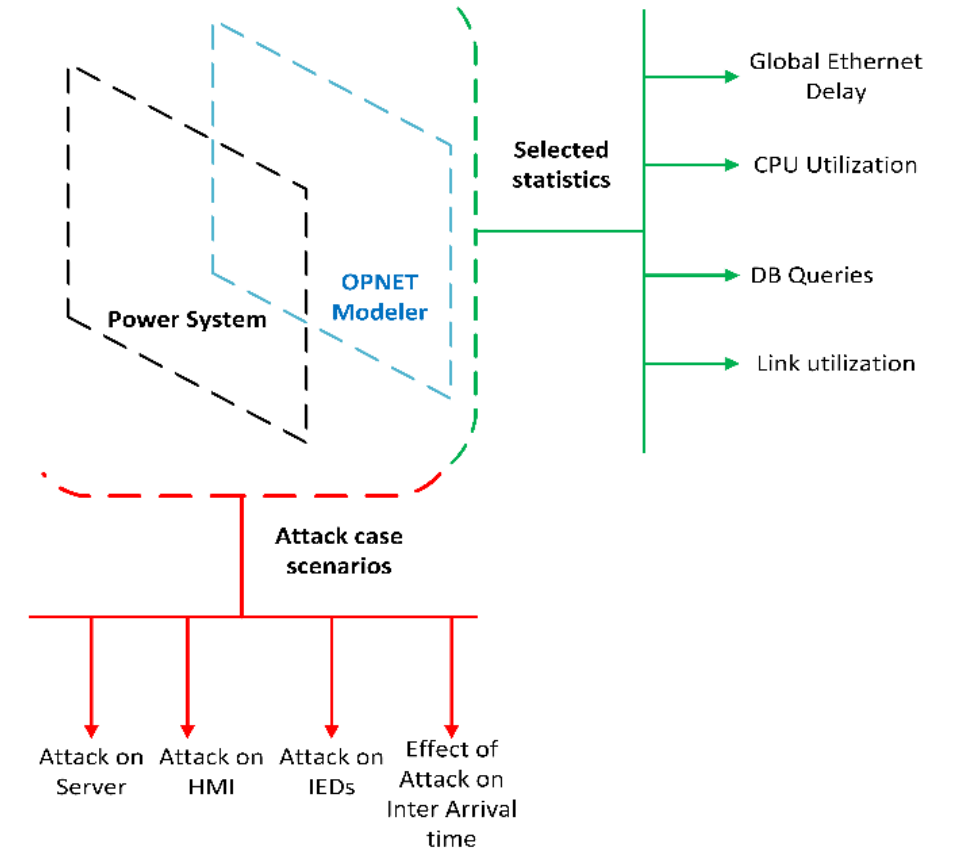
Figure 8. Simulation and model system framework.